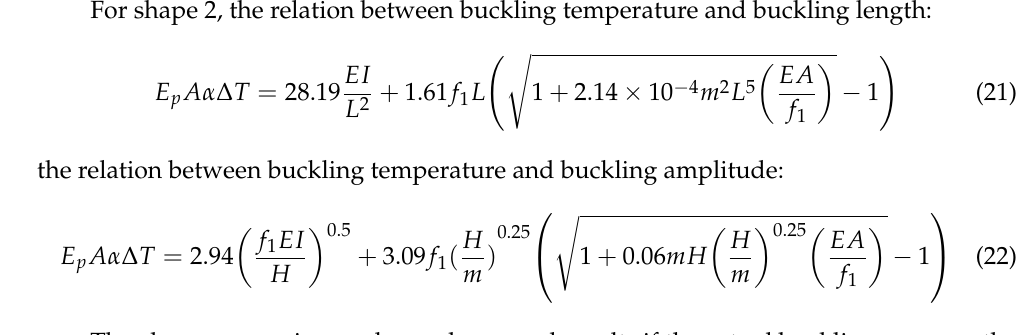
the relation between buckling temperature and buckling amplitude: E p A α ∆ T =